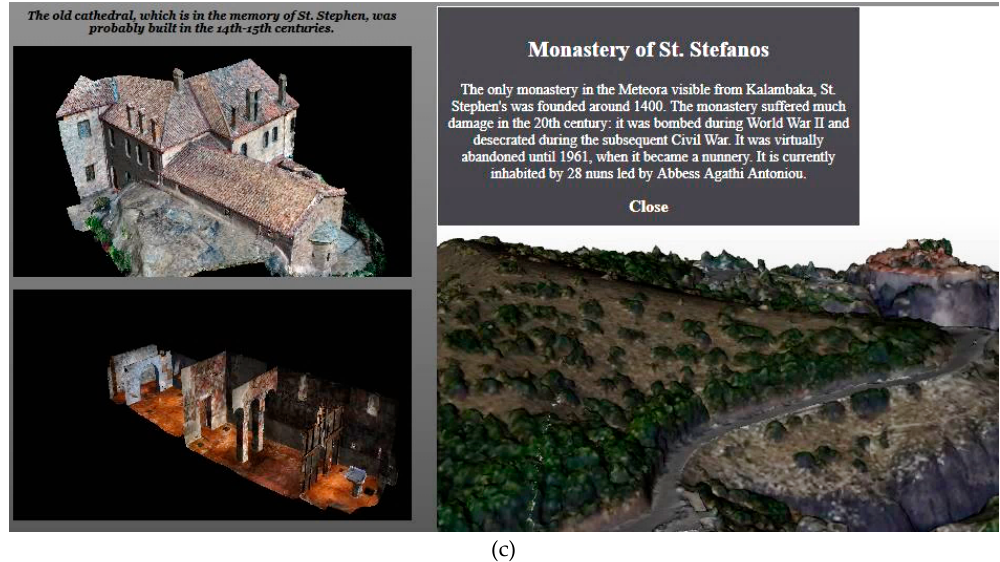
Figure 13. The interactive retrieval tool enables the access to heterogeneous data via 2D and 3D viewports ( a ) Emulation of the subpage with the detailed documentation of Pixari rock ( b ) Image collection of Roussanou Monastery ( c ) 3D models’ collection of St. Stephen’s Monastery.